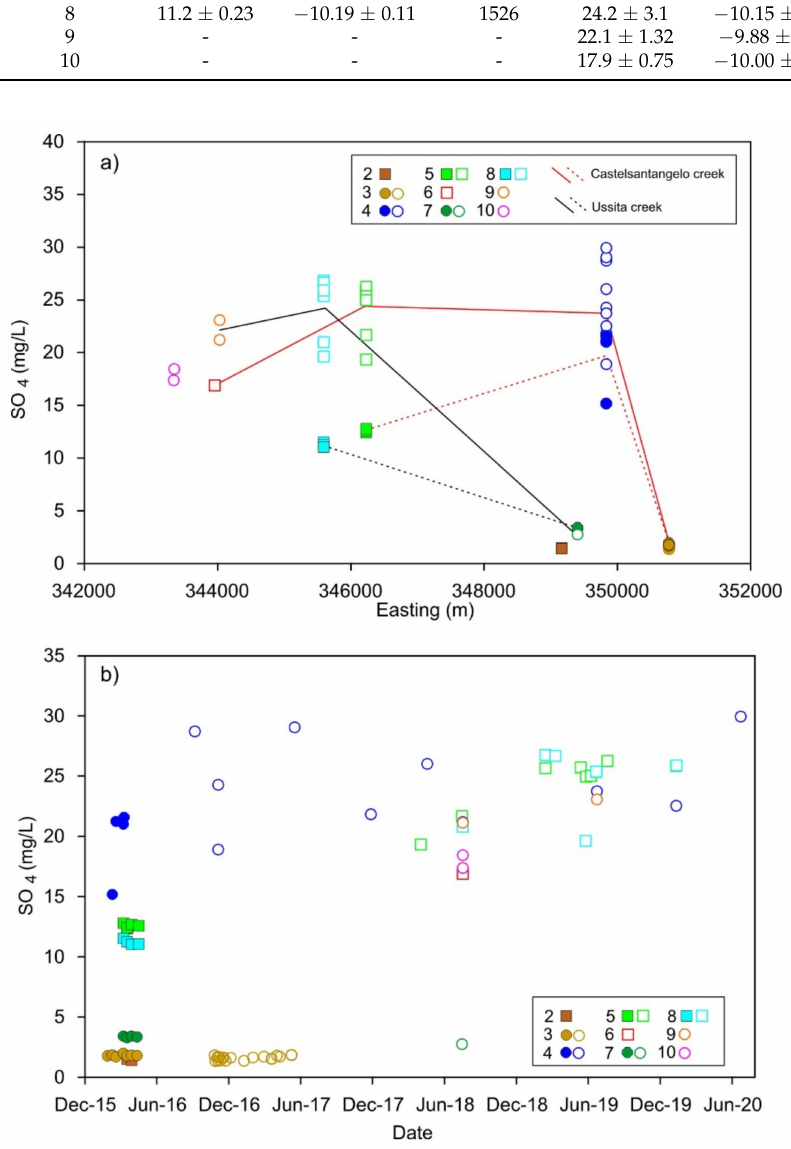
Figure 7. ( a ) SO 4 content (mg/L) of the water sample of the monitoring point (pre: filled symbols and post seismic: empty symbols) moving downstream the two analyzed basins. The lines represent the trend of the average SO 4 content (Table 3) on the monitoring points (the dashed line represents the pre seismic, while the solid one represents the post-seismic period). ( b ) SO 4 content (mg/L) on the water sample of the monitoring point (pre: filled symbols and post seismic: empty symbols) vs. sampling